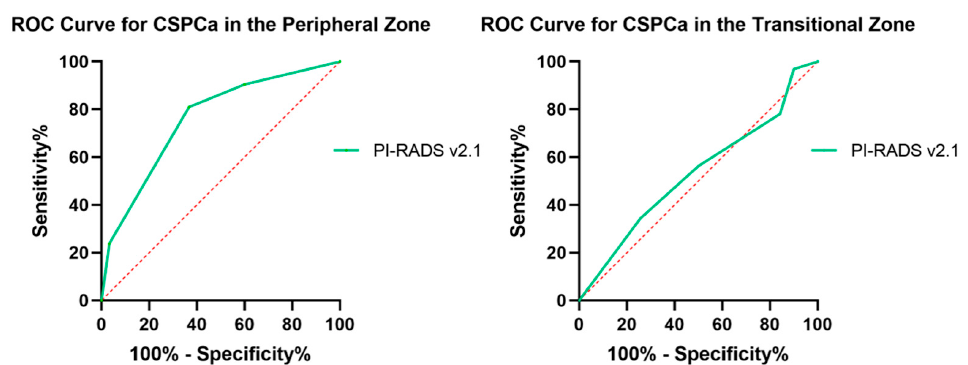
Figure 3. ROC curves of PI-RADS v2.1 in predicting CSPCa in the peripheral zone and the transi- tional zone.